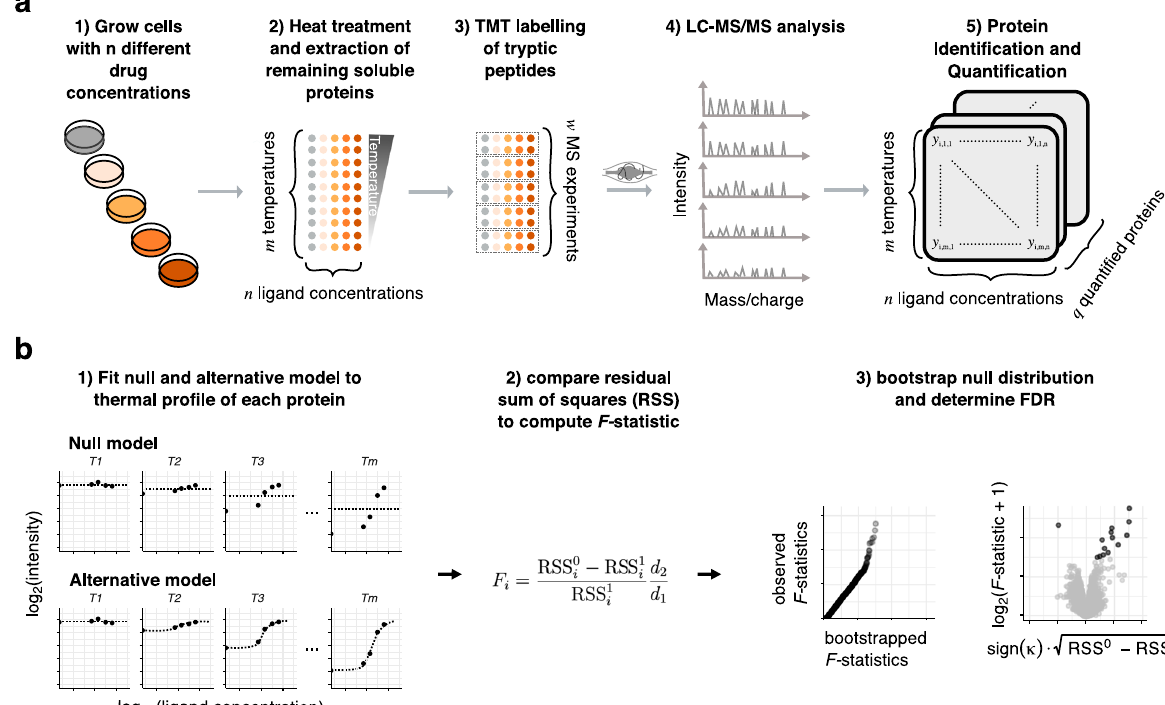
Fig. 1 Illustration of the 2D-TPP experimental setup and our computational analysis approach. a 2D-TPP protocol: Cells are grown in the presence of n different concentrations of a ligand of interest. Each sample is divided into m aliquots, each of which is subjected to one of m temperatures, and the remaining soluble proteins are extracted. Proteins are digested with trypsin and labeled with TMT, such that one set of TMT labels is used for all concentrations and two adjacent temperatures. w = m /2 MS runs are performed, peptides are identi fi ed by database search and quanti fi ed signal is aggregated at the protein level. b Illustration of fi tted curves under the null and alternative model, and how obtained residuals are used to fi nd proteins signi fi cantly altered in thermal stability — and thus potential ligand interactors — via an F -statistic (example fi ts for the null and alternative model are shown in Supplementary Fig. 1). The q – q plot on the right compares bootstrapped and observed F -statistics. Although the majority of quantiles of the two distributions align, the top observed F -statistics, corresponding to the true positives in the dataset, are shifted off-diagonal. The results can be ffiffiffiffiffiffiffiffiffiffiffiffiffiffiffiffiffiffiffiffiffiffiffiffiffiffi p represented as volcano plots, highlighting signi fi cant hits. RSS: residual sum of squares; sign ð κ Þ ´ RSS 0 (cid:2) RSS 1 : measure of effect size — how much more variance is explained by the alternative model compared to the null — and direction, i.e., a positive sign for stabilized proteins, negative for destabilized ones; log 2 ( F -statistic + 1): the transformation is used for visualization purposes only, the addition of 1 guarantees that logarithm-transformed values remain bounded as F approaches